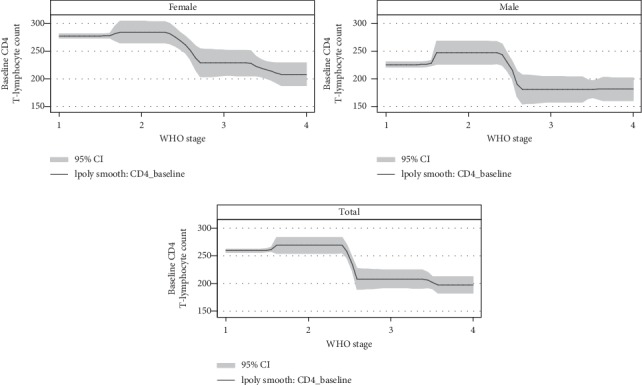
The polynomial with the 95% confidence interval of the WHO stage and baseline CD4 count among ART-naïve HIV-infected adolescents and adults in northern Ethiopia, n = 19525.